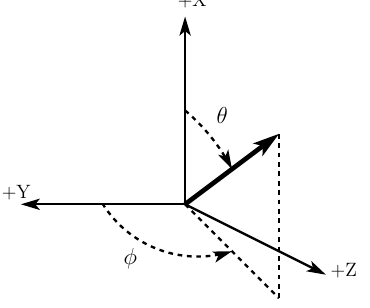
Figure 2. Definition of spherical coordinates θ (colatitude) and φ (azimuth) in the spacecraft-fixed reference frame as used for the representation of antenna axes.